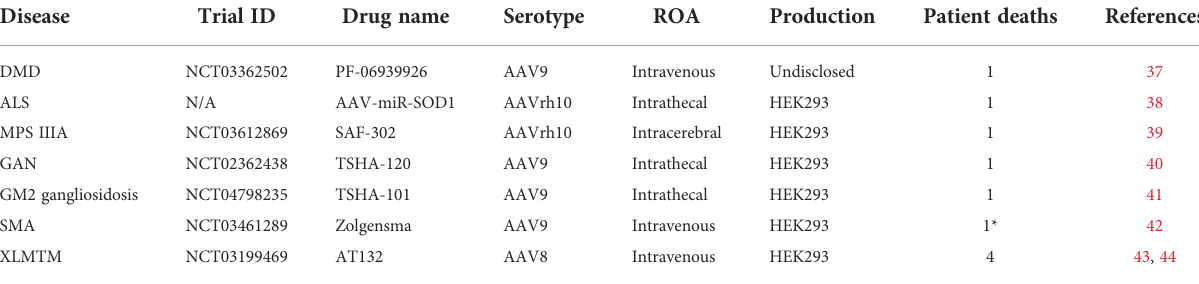
TABLE 2 Patient deaths that occurred in AAV-related clinical trials.